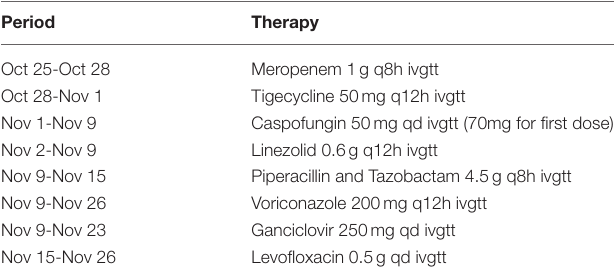
TABLE 2 | The details of therapy strategies.